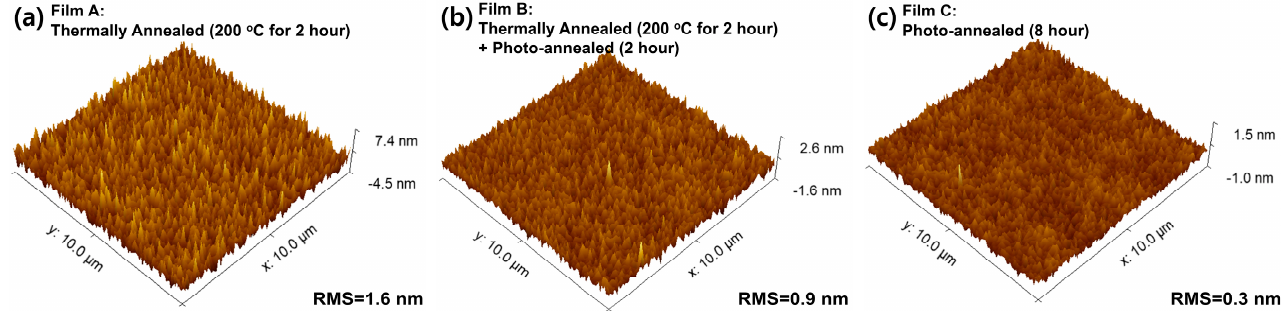
Figure 2. Scanning probe microscopy images of the Y 2 O 3 films with different annealing treatments: ( a ) thermally annealed films, ( b ) thermally and photochemical annealed films, and ( c ) photochemical annealed films, respectively.